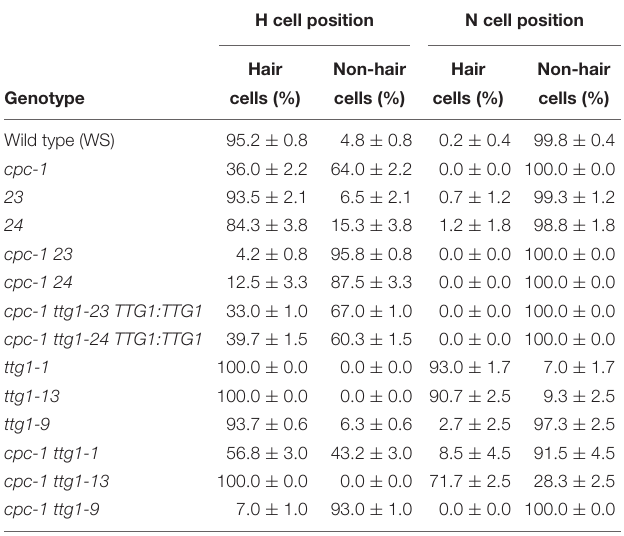
TABLE 1 | Specification of cell types in the root epidermis 1 .